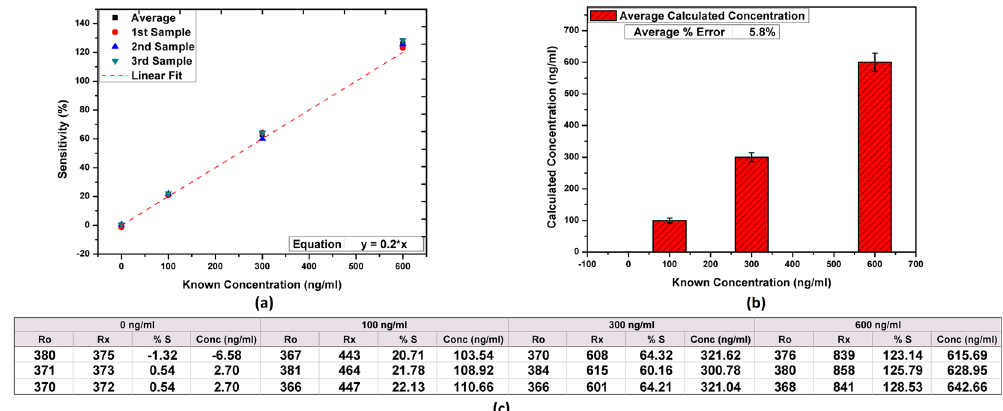
Figure 7. Results of IgG detection using POC setup ( a ) calibration readings for known concentrations, ( b ) difference between calculated and known values, and ( c ) presenting the table with all actual recorded readings from POC diagnosis